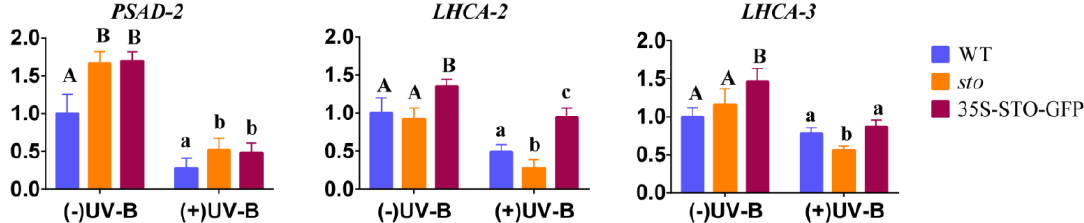
Figure 8. Expression profile of photosynthesis genes before and after UV-B treatment. The WT, sto, and 35S-STO-GFP seedlings were grown in white light for seven days and then subjected to a four-hour UV-B treatment (0.6 W / m 2 ). Error bars indicate the SEM of three independent biological and technical replicates. Di ff erent capital letters and lowercase letters indicate significant di ff erences between gene relative expression of those seedlings grown without or with UV-B radiation, respectively ( P < 0.05, Dunnett’s multiple). Actin2 was used as an internal reference gene.